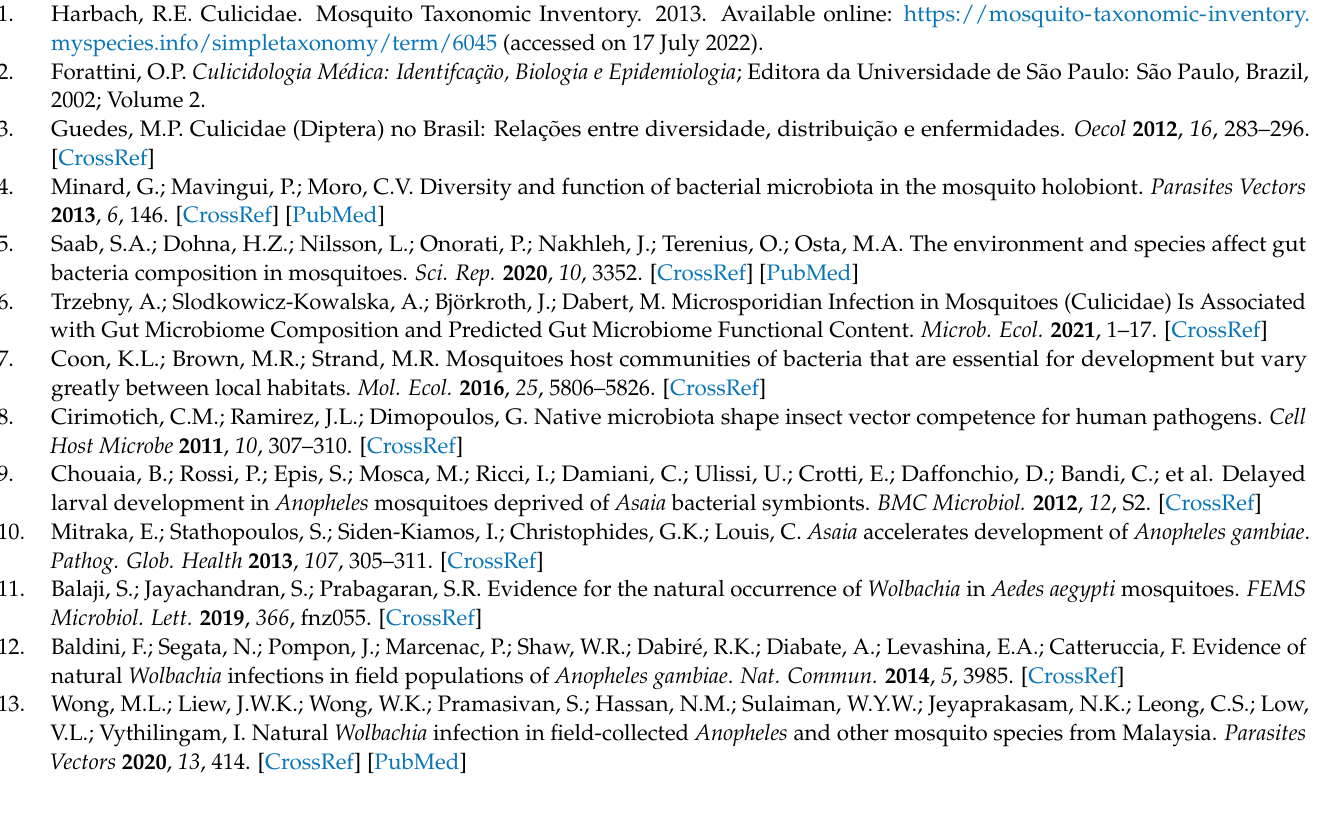
curve. Count of ASVs per given sequencing depth in each mosquito sample. Each line corresponds to a mosquito sample. Figure S4: The illustration represents ANCOM analysis. Twelve taxa were the most abundant and are marked 1 to 12 from right to left. Figure S5: Heatmap of bacterial sequences with taxonomic assignment to genus level in each mosquito sample. Each row represents a bacterial taxon and each column corresponds to a mosquito species. Abundance data are assigned colors across a gradient from yellow (higher bacterial abundance) to blue (lowest bacterial abundance). Table S1: Count of 16S rRNA raw data and contigs in each mosquito sample. Table S2: ASVs count in each sample and mosquito species. Table S3: Shannon index of each mosquito sample. Table S4: Pairwise permanova results from unweighted and weighted Unifrac distances. Table S5: ANCOM analysis. Percentile abundances of features by group. Table S6: Relative abundance of each ASV in each mosquito species. Table S7: Number of bacterial interactions per mosquito species and number of bacterial taxa related to